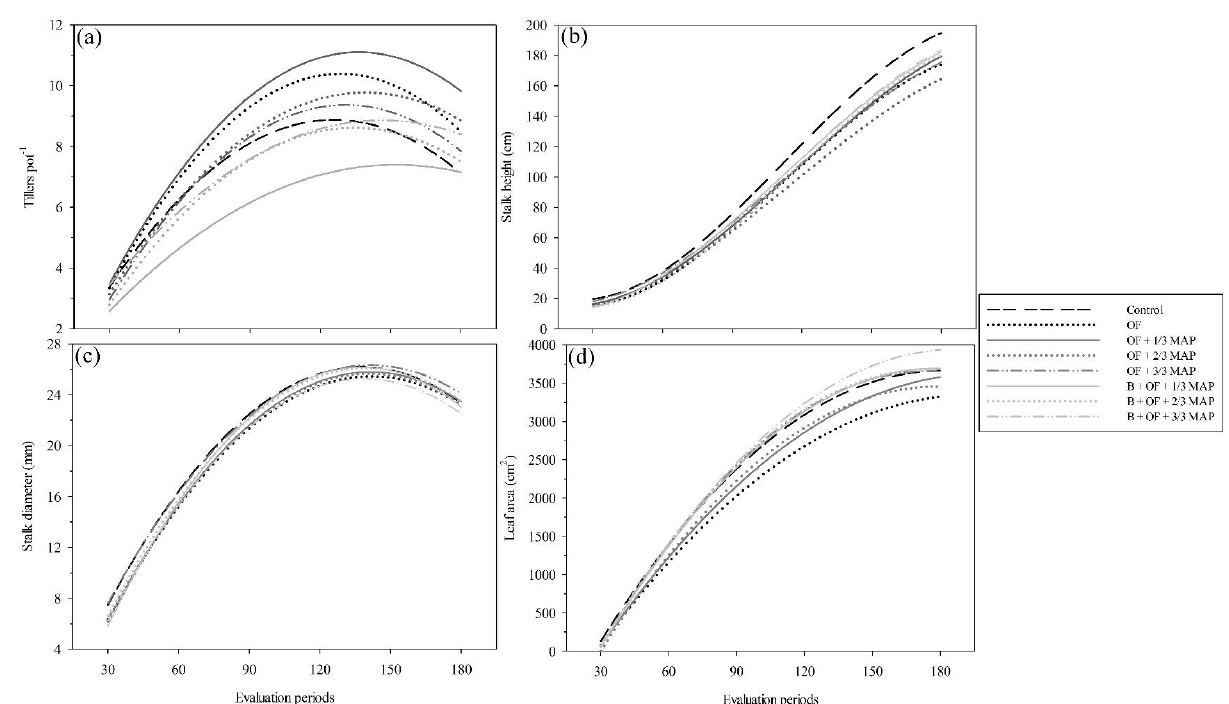
Figure 3. Regression curves along the evaluation periods (30, 60, 90, 120, 150, and 180 DAP) for tillers pot − 1 ( a ), stalk height ( b ), stalk diameter ( c ), and leaf area ( d ) of sugarcane under the association of organomineral fertilizer (OF), B. velezensis (B), and doses of mono ammonium phosphate (MAP).